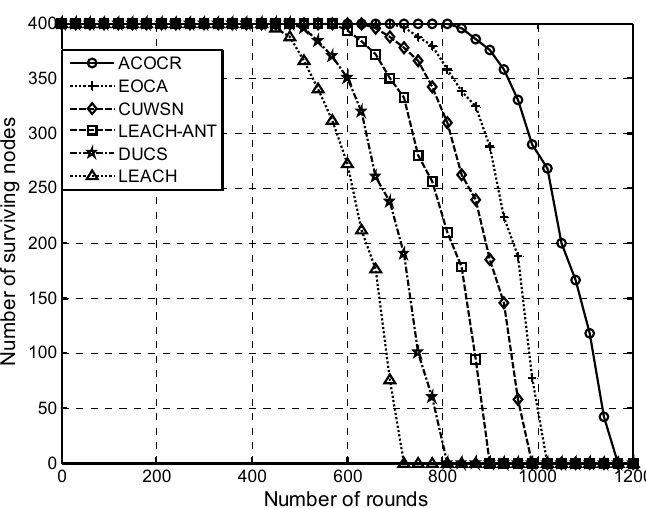
Figure 4. The number of surviving nodes versus the number of rounds for the six algorithms.